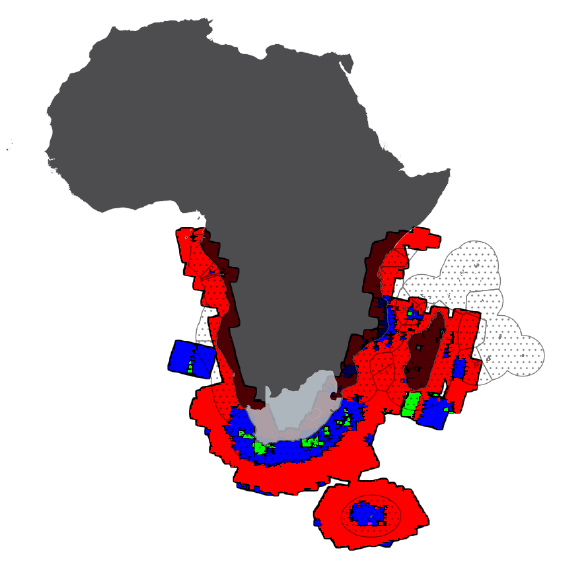
Figure 7. SAR Image Coverage in 2019 (Hybrid version = Reduced Radarsat-2 + Sentinel-1). Where Green, Blue and Red represent High, Medium, Low coverage